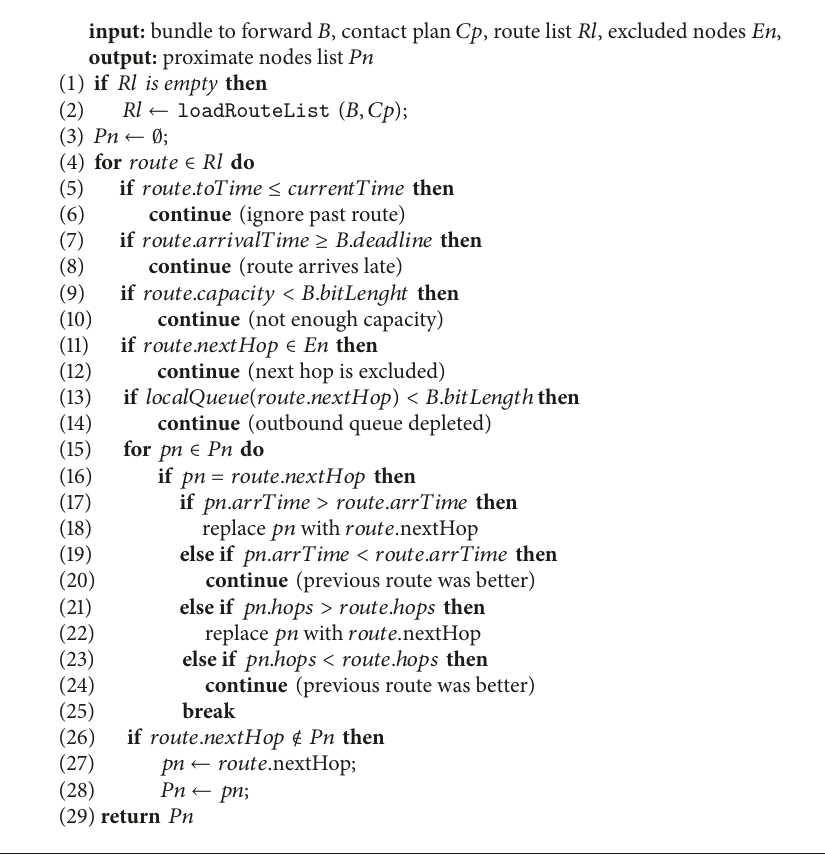
Algorithm 2: CGR: Identify proximate node list.